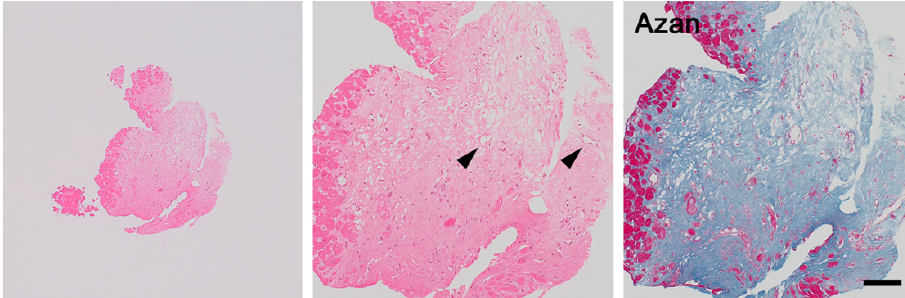
Figure 4. Fibrous phase of cardiac sarcoidosis. Although it is quite difficult to diagnose cardiac sarcoidosis in endomyocardial biopsy, confluent fibrosis and lymphangiogenesis (arrowheads) may be helpful for diagnosing cardiac sarcoidosis. Bar = 500 μ m for a lower magnification field, 100 μ m for higher magnification fields.